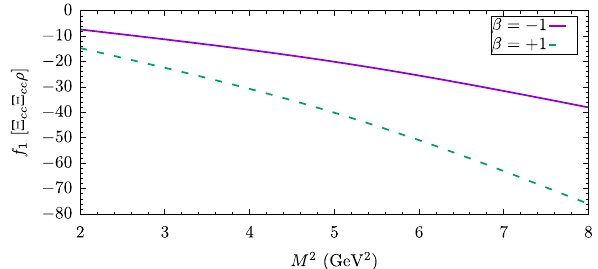
Fig. 2 The dependence of the coupling constant f 1 for Ξ cc Ξ cc ρ on M 2 for the shown values of β and at